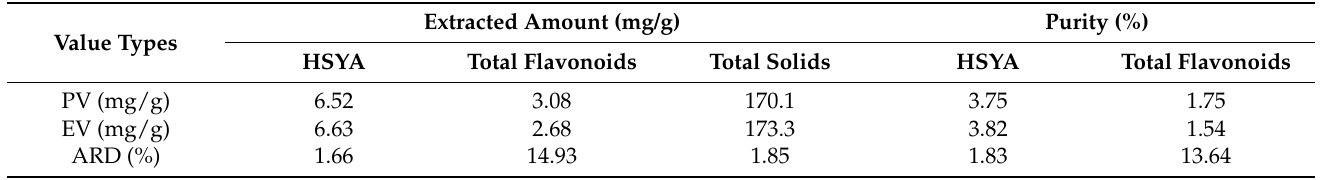
Table 5. The results of experimental point